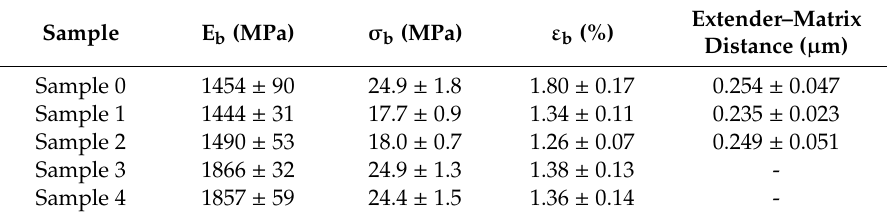
Table 4. Summary of the samples’ mechanical and morphological